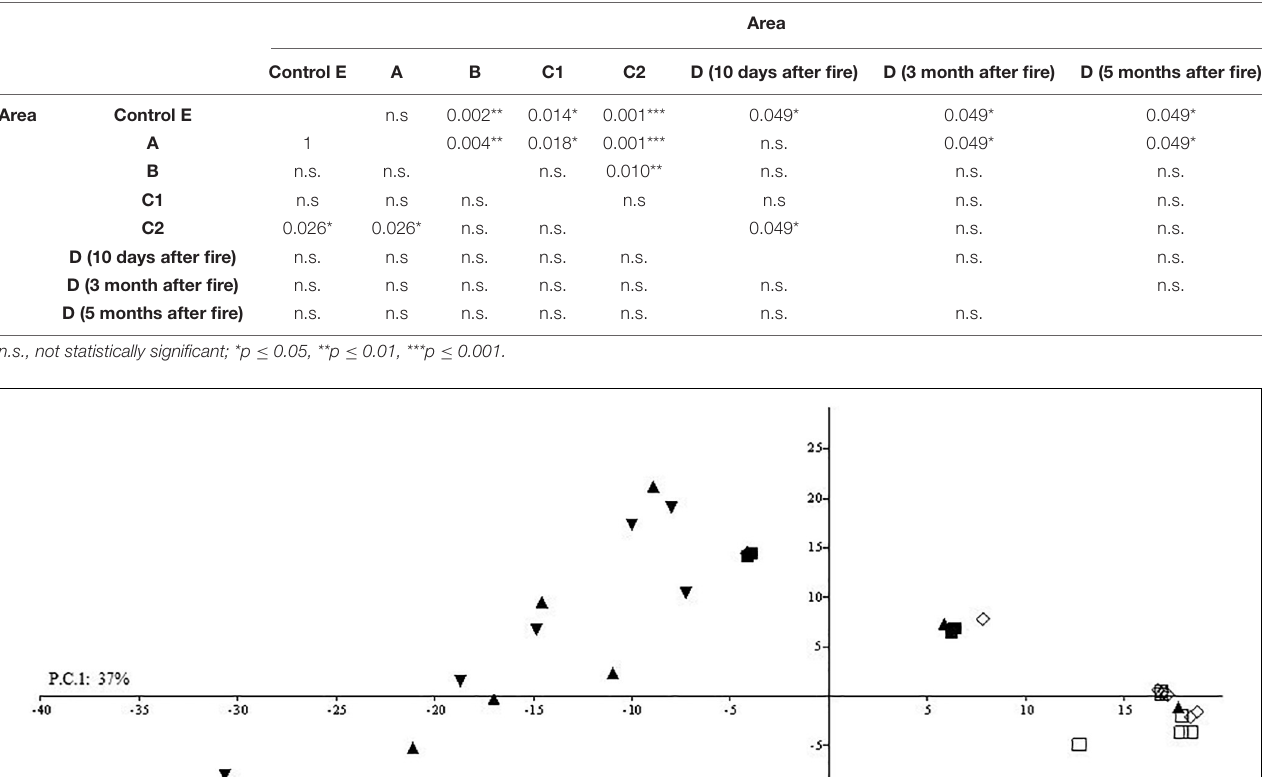
TABLE 4 | Kruskall Wallis test p -values.